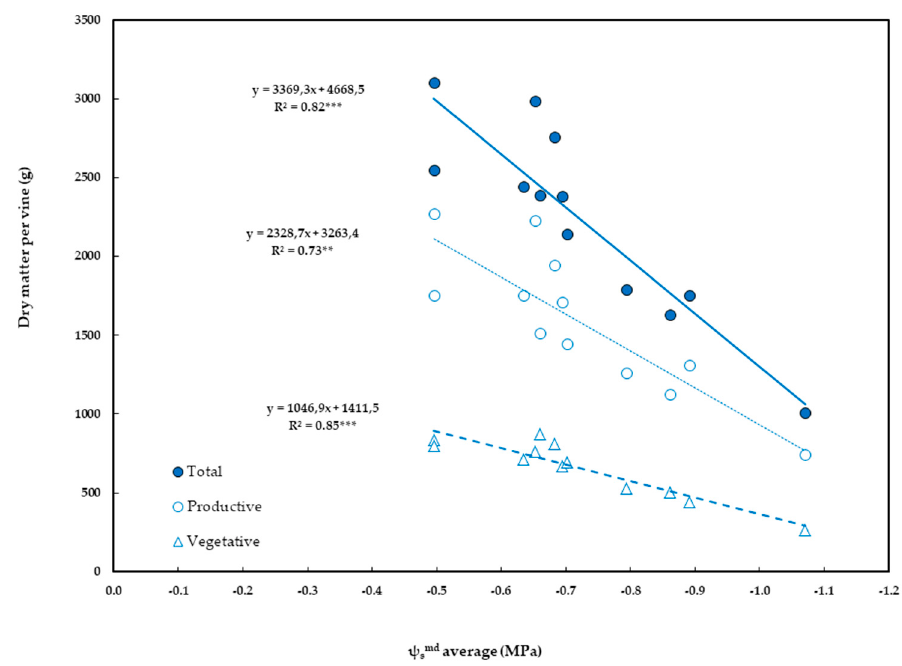
Figure 3. Relationship between the average value for the whole crop cycle of stem water potential measured at midday and total dry matter production (g/vine) and broken down into dry matter of bunches (productive) and dry matter of the vegetative organs (vegetative). **, ***, indicates a significance at p < 0.01 and p < 0.001, respectively.